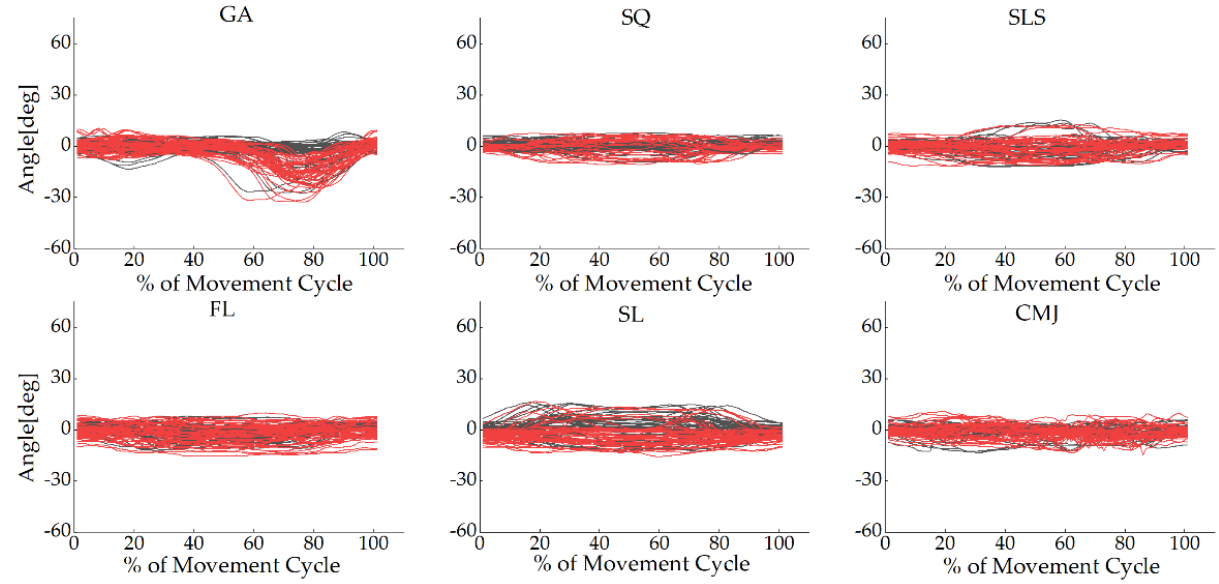
and counter-movement jump (CMJ). The black lines represent the OptiTrack system, while the red lines represent the Perception Neuron ® system. The Y -axis depicts joint angles in degrees, while the X -axis depicts the movement cycle in %.